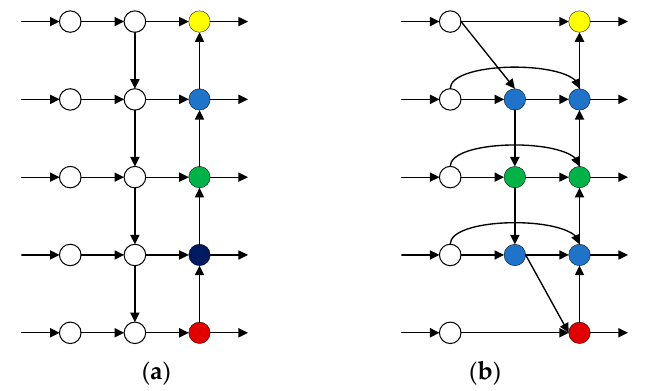
Figure 6. PANet ( a ) and BiFPN ( b ) base module